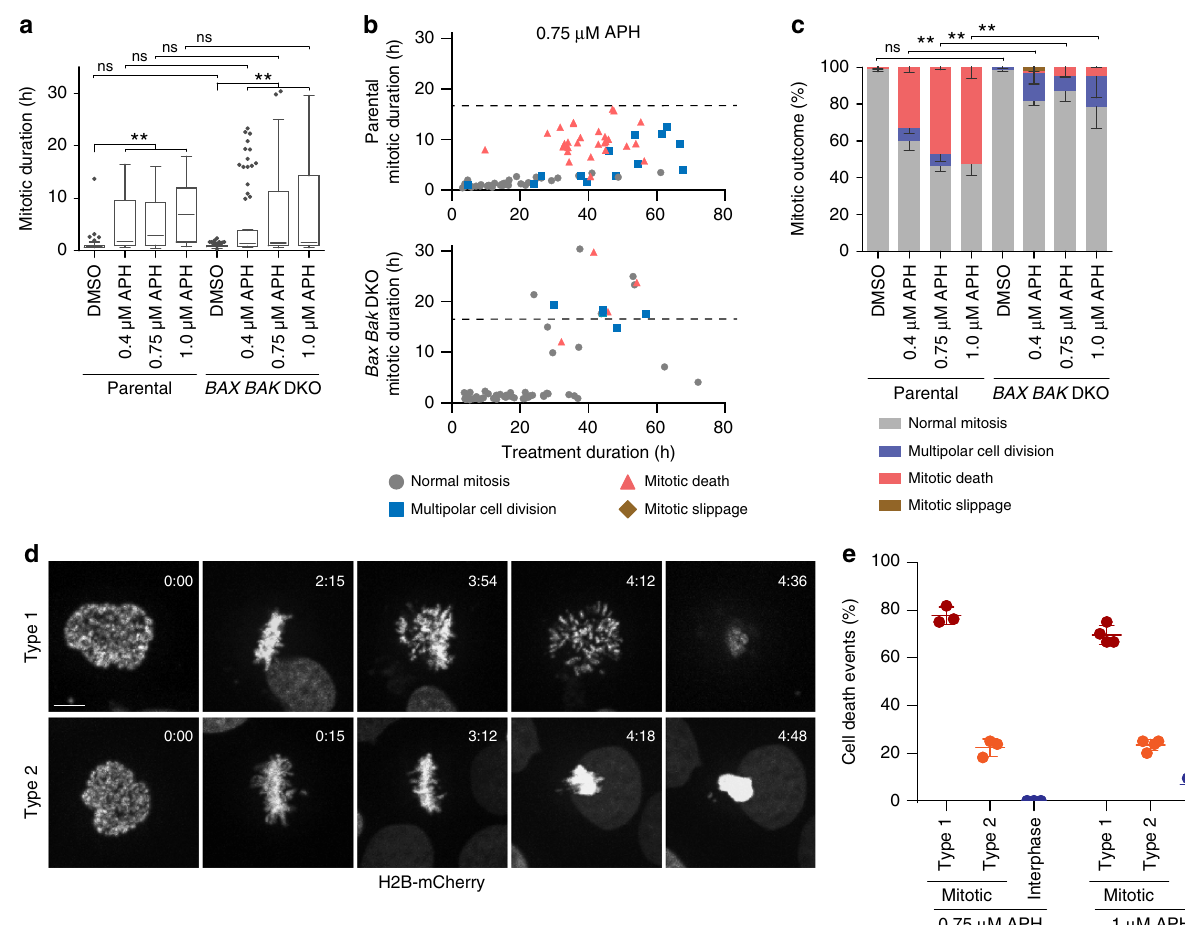
Fig. 3 Replication stress induces distinct types of mitotic death. a Mitotic duration of HeLa parental and BAX BAK DKO cells following treatment with DMSO or APH (three biological replicates using independent clones scoring n ≥ 32 mitotic events per condition are compiled in a Tukey box plot, Mann – Whitney test, ** p < 0.01, ns = not signi fi cant). b Two-dimensional dot plots of mitotic duration and outcome in 0.75 µ M APH treated HeLa parental and BAX BAK DKO cells from ( a ). The dashed line identi fi es the longest duration mitosis observed in the parental cells. c Outcome of the mitotic events in ( a ) (mean ± s.e.m., n = 3 biological replicates using independent clones, Fisher ’ s Exact Test, ** p < 0.01, ns = not signi fi cant). d Representative images of Type 1 and Type 2 mitotic death in 1 µ M APH treated HT1080 6TG H2B-mCherry cells. Time is shown as (h:min) relative to the fi rst image of the series. Scale bar represents 10 µ m. e Quantitation of cell death events in 0.75 and 1.0 µ M APH treated HT1080 6TG H2B-mCherry cultures (mean ± s.d., n = 3 biological replicates scoring ≥ 57 mitotic events per condition for 0.75 µ M APH and n = 4 biological replicates scoring ≥ 91 mitotic events per condition for 1.0 µ M APH). Source data are provided as a Source Data fi WAPL and BAX/BAK may function in the same pathway. To test this, we created HT1080 6TG H2B-mCherry BAX BAK DKO cells (Supplementary Fig. 6f). We then treated HT1080 6TG H2B- mCherry, WAPL depleted HT1080 6TG H2B-mCherry, or HT1080 6TG H2B-mCherry BAX BAK DKO cells with 1 µM APH and visualized mitotic outcomes with live cell imaging (Fig. 5c, d and Supplementary Fig. 6g). WAPL depletion completely suppressed Type 1 mitotic death with no signi fi cant effect on Type 2 mitotic or interphase death (Fig. 5d). Similarly, BAX BAK DKO also largely suppressed Type 1 mitotic death with no signi fi cant effect on Type 2 mitotic or interphase death (Fig. 5d). Together, these data indicate that Type 1 mitotic death is WAPL and BAX/BAK dependent.